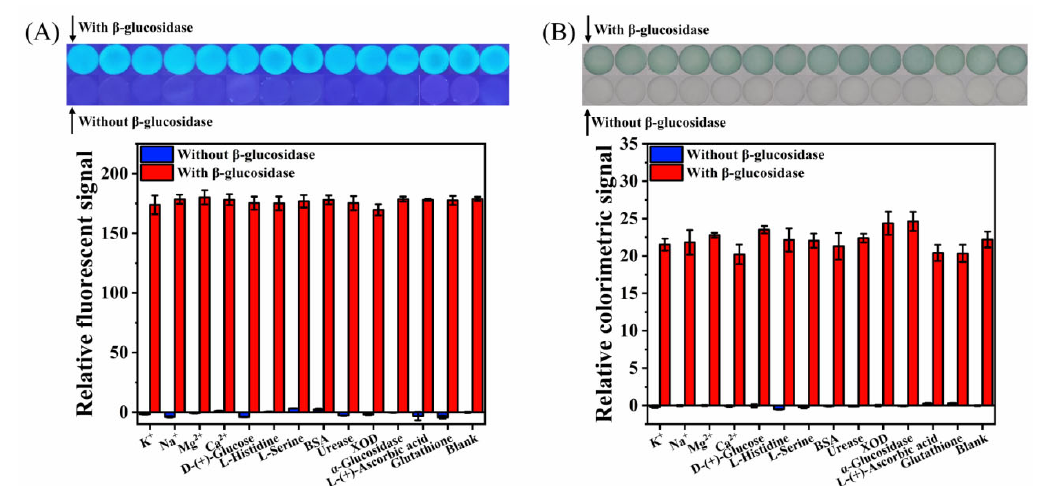
Figure 8. Selectivity and interference study of the paper ‐ based device for β‐ glucosidase detection: ( A ) fluorescence, ( B ) colorimetry.